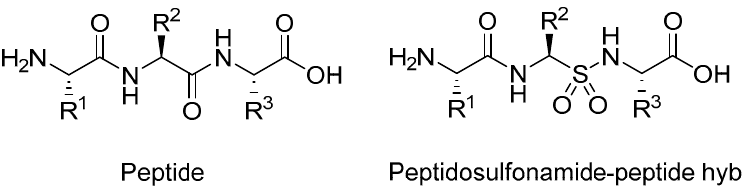
Figure 23. Structure of a regular peptides compared to sulfonamide analogue.